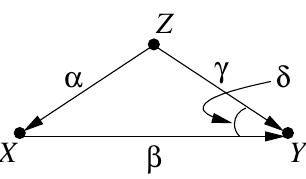
Figure 2: A linear model with interaction, demonstrating baseline and variable-effect biases. The former is proportional to γα and independent of δ ; the latter is propor- tional to δα and independent of γ , reflecting effect